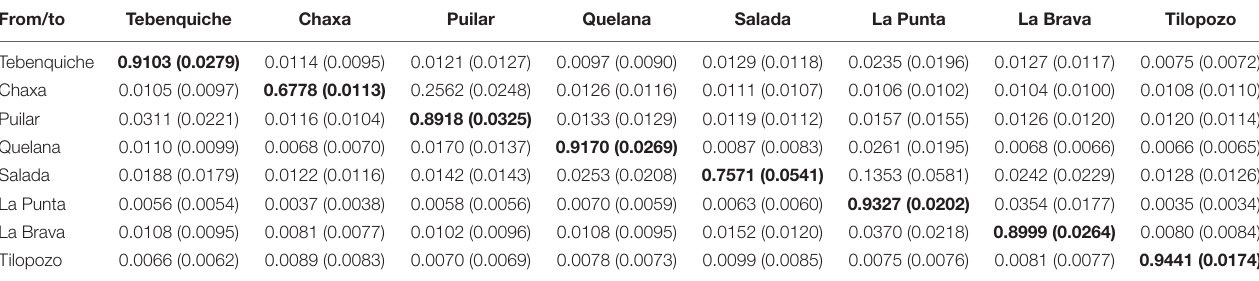
TABLE 4 | Estimated contemporary migration rate for Heleobia populations of Atacama Saltpan obtained using 11 microsatellite loci. From/to Tebenquiche Puilar Quelana